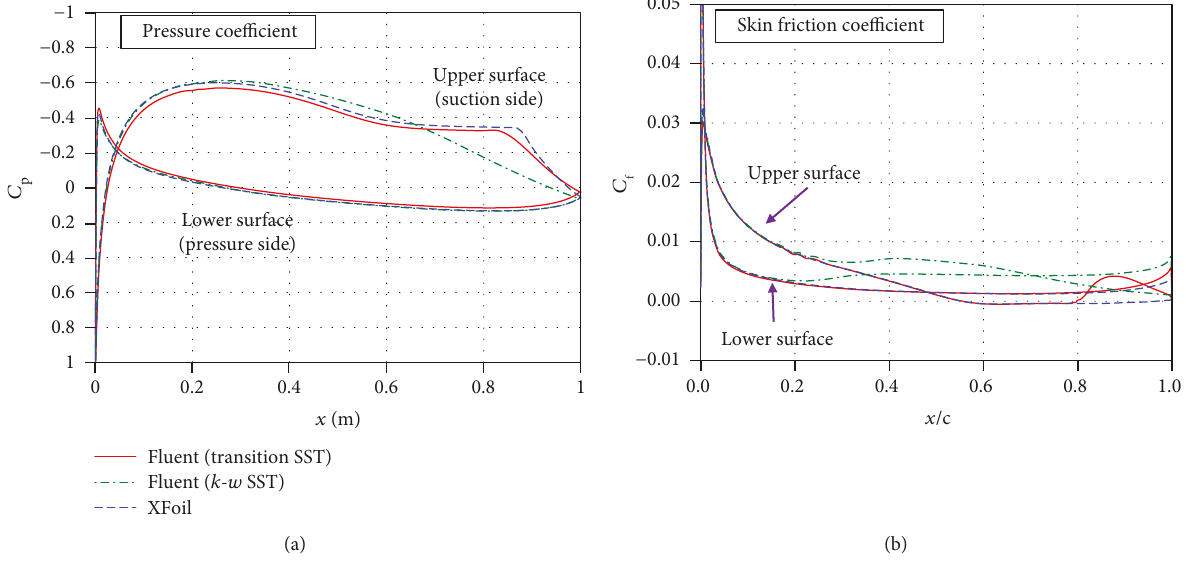
Figure 2: Comparison of XFOIL and CFD results for an airfoil at low Reynolds